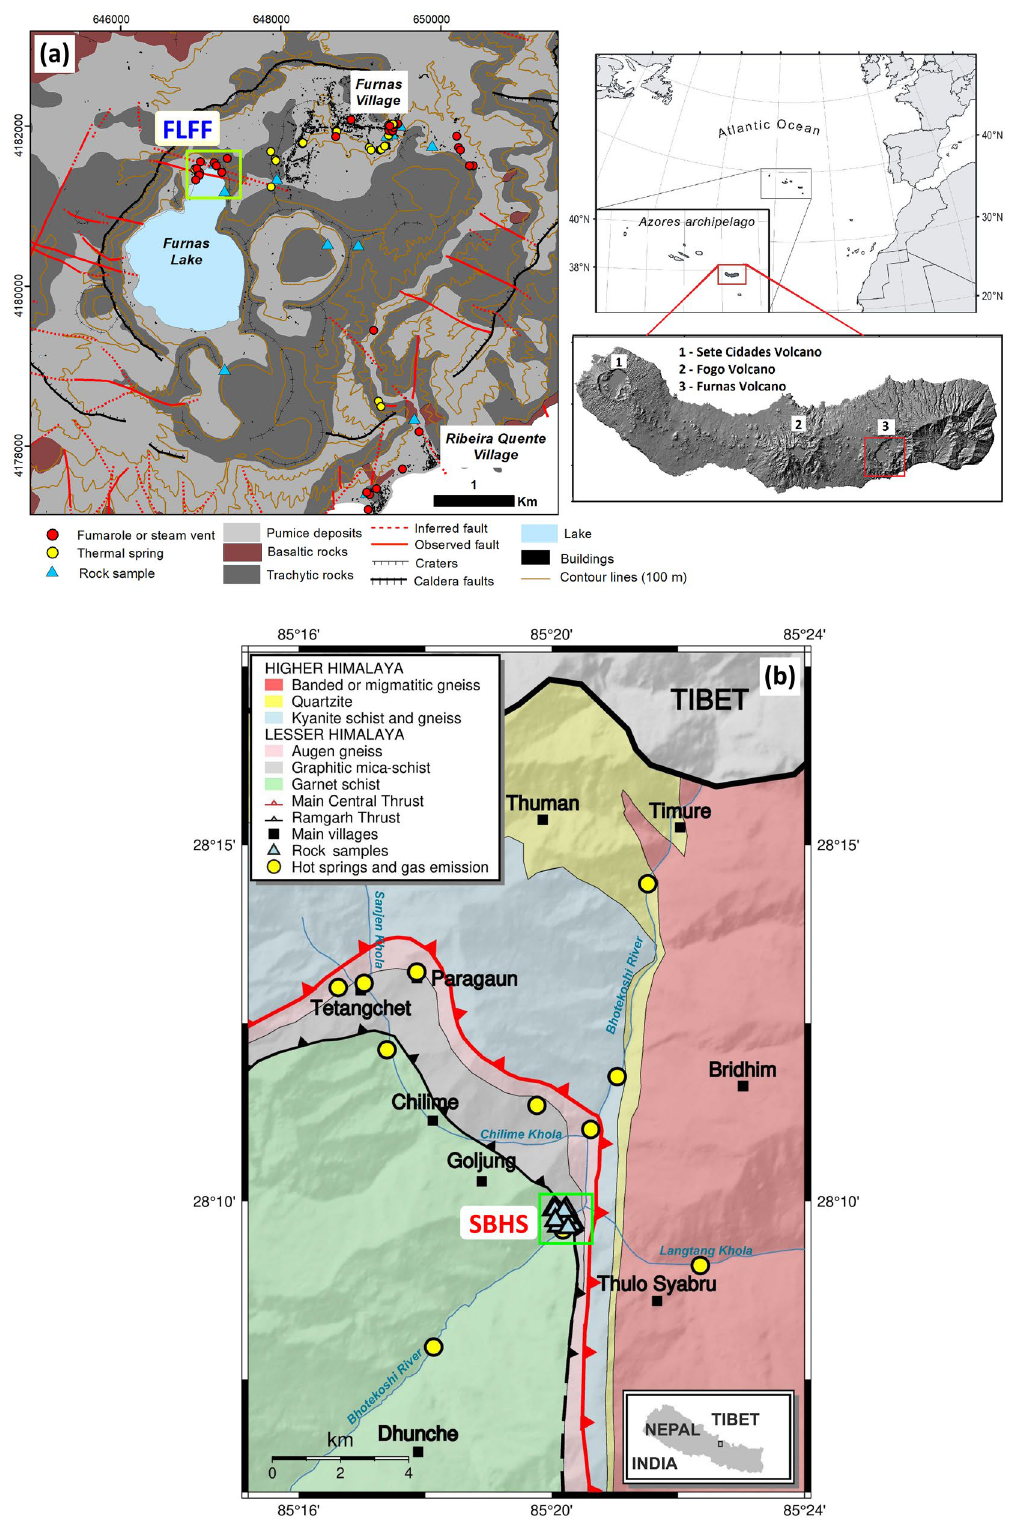
Figure 1. (a) Geological map showing the location of the Furnas Lake Fumarolic Field (FLFF) in mantellic and volcano-magmatic context (Azores, Portugal). The insets show the location of the Azores and of the Furnas Volcano on the São Miguel Island. ( b ) Geological map showing the location of the Syabru-Bensi Hydrothermal System (SBHS) in metamorphic and active tectonic context (Central Nepal). The inset shows the location in the Nepal